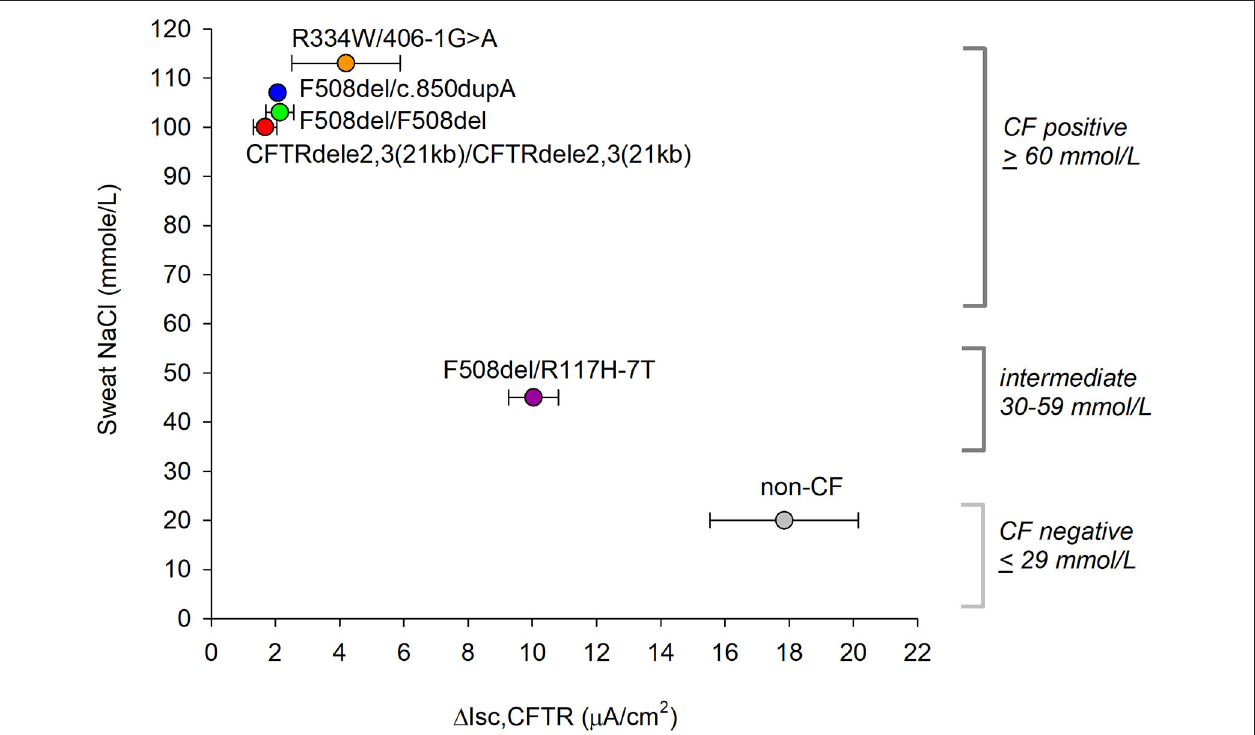
FIGURE 6 | Relation between ex vivo CFTR current measurements and clinical sweat chloride concentrations. Official standards for CF diagnostics based on sweat chloride are shown on the right. 1 I CFTR is presented as mean ± SE values of CFTR inhibitor-sensitive current recorded in forskolin plus VX-770 stimulated cells without CFTR corrector treatment. A relation between the two measures appears significant by Pearson correlation with r = − 0.953, p = 0.003, normality passed (Shapiro-Wilk), p = 0.917.